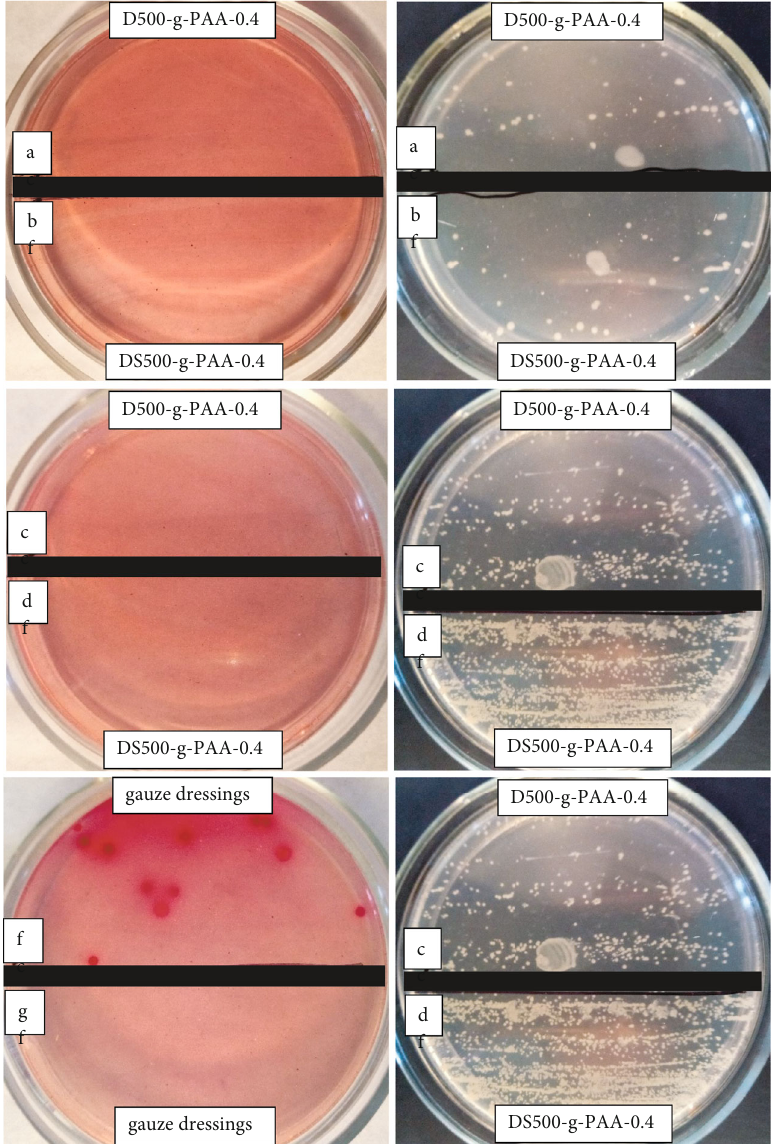
Figure 5: Cultivation of bacteria using Endo (left) and yolk-salt (right) agar media after removal of (a, b) cefuroxime-loaded hydrogels from infected wound; (c, d) miramistin-loaded hydrogels; (f, g) gauze